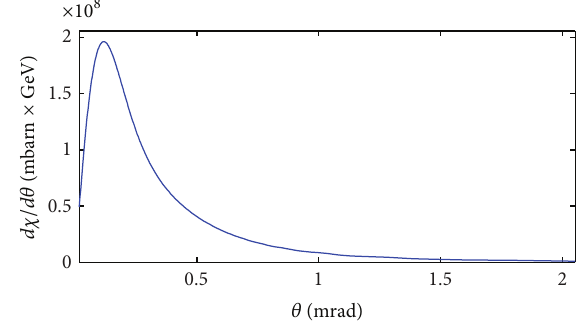
Figure 1: Bremsstrahlung calculations for a Pb-208 projectile with energy 7 TeV × 𝑍 incident on a lead target. The dashed line shows reference cross section (1) and the full drawn curve shows the present results.